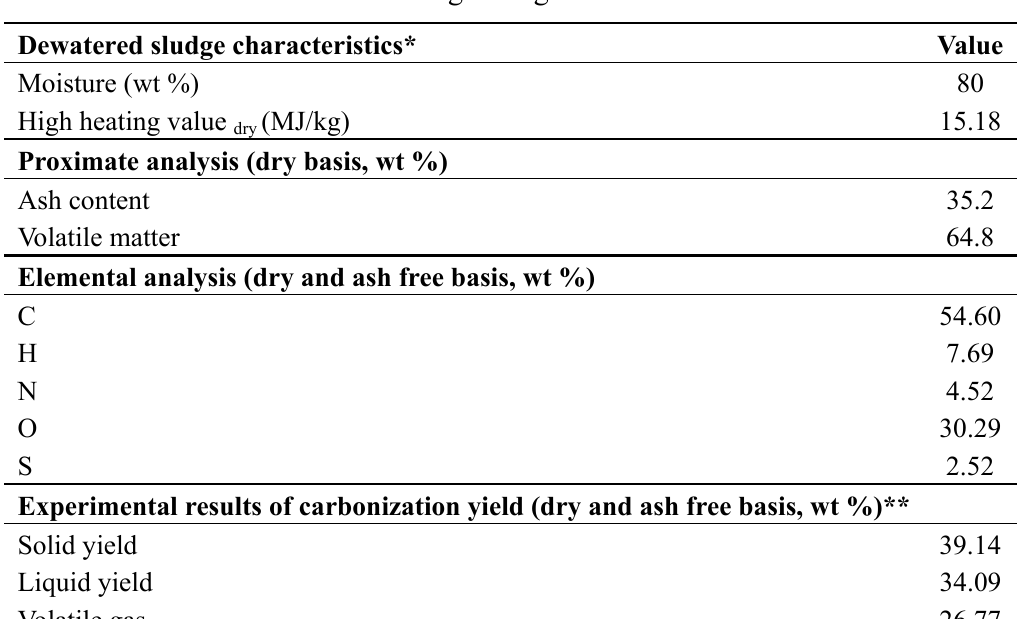
Table 1. Sewage sludge